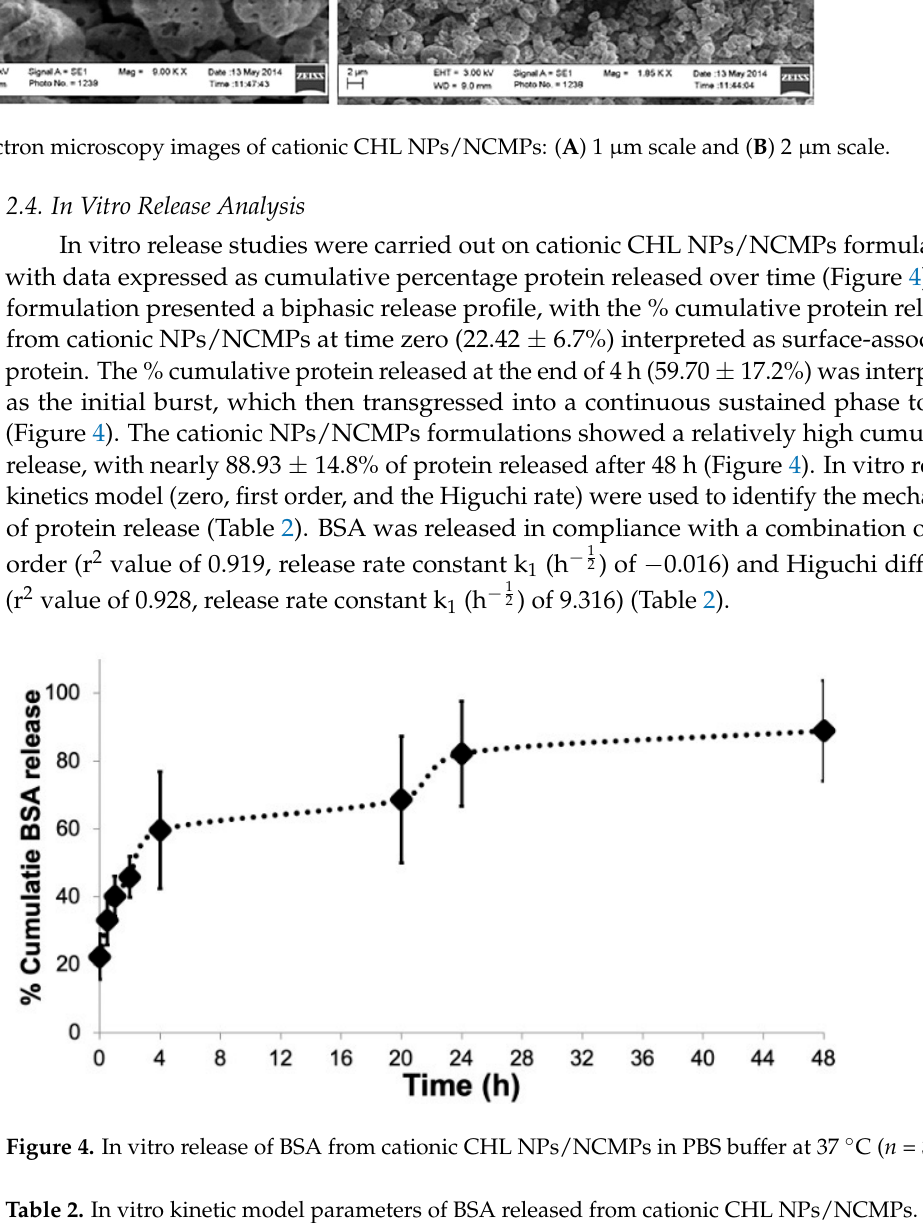
Figure 4. In vitro release of BSA from cationic CHL NPs/NCMPs in PBS buffer at 37 °C ( n = 3). Table 2. In vitro kinetic model parameters of BSA released from cationic CHL